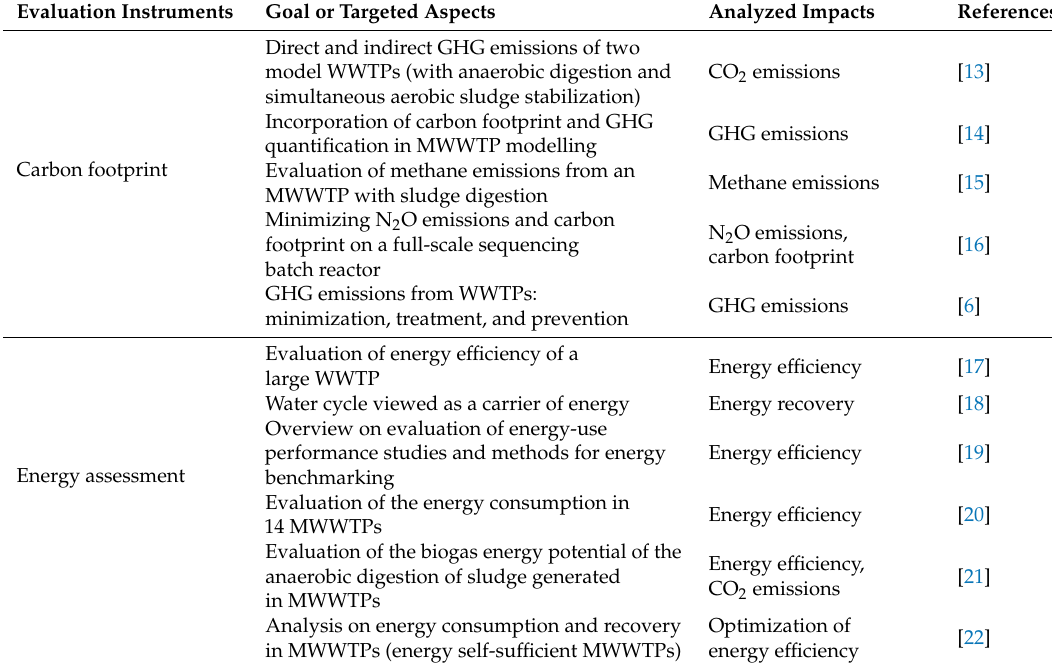
Table 1. Overview of the most relevant studies for energy performance and greenhouse gas (GHG) emission assessments of wastewater treatment